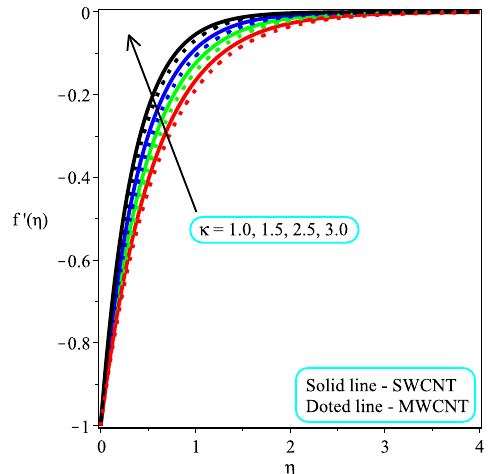
Figure 3. Repercussion of Ω with Φ = 0.1, M egt = 2, κ = 2, ω = π /4 on velocity profiles.